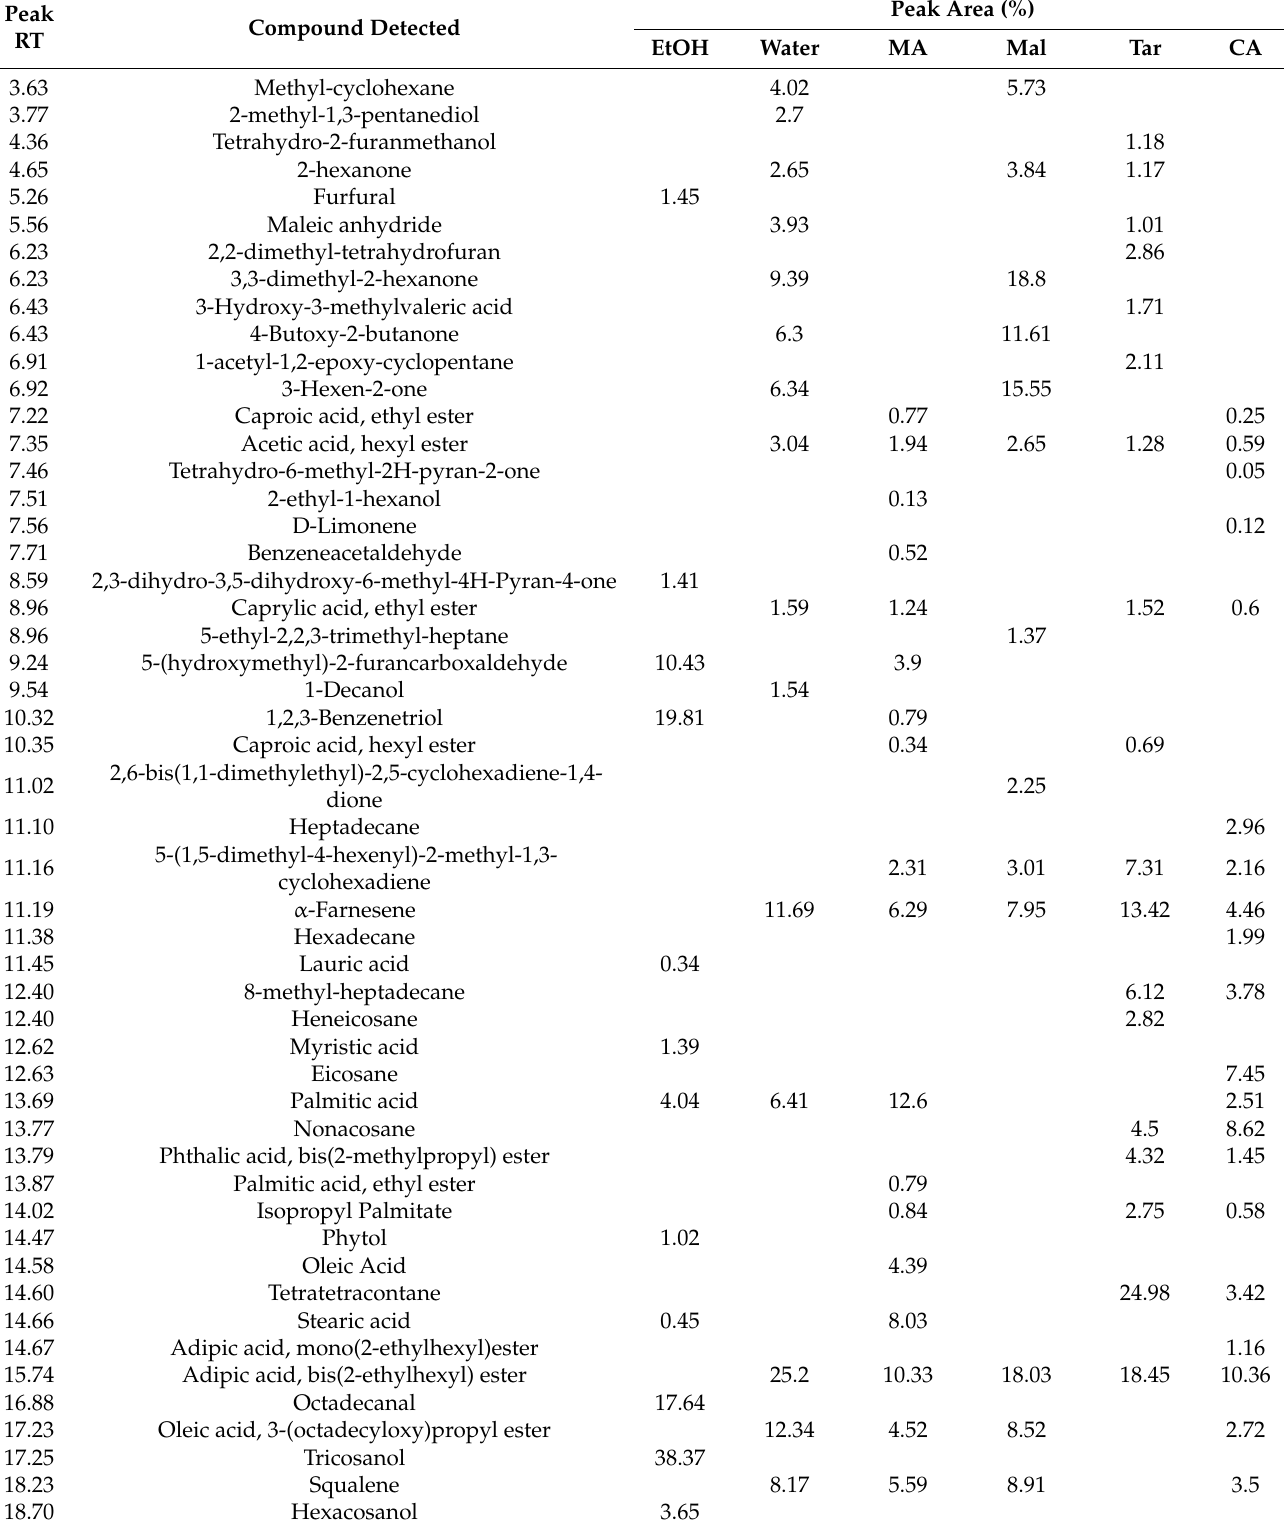
Table 5. Chemical components of volatile compounds from extracts of Chamaenerion angustifolium (L.) Scop. analyzed by